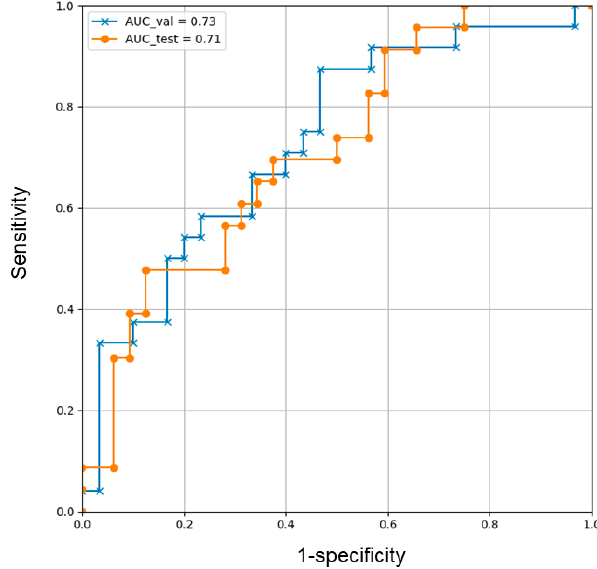
Figure 5. The receiver operating characteristic curves of the validation (blue) and test (orange) datasets. Area under the curves in the validation and test datasets were 0.73 and 0.71, respectively.